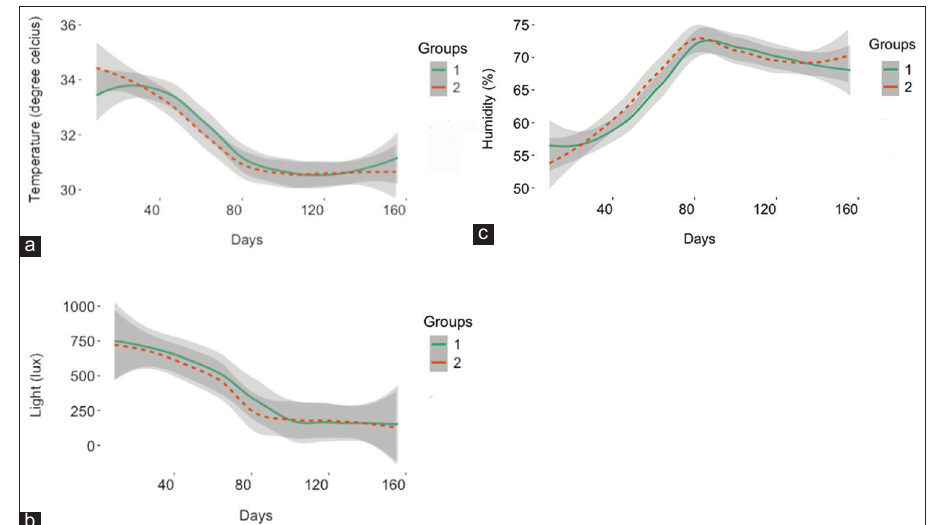
Figure-3: Trend in environmental temperature, humidity, and light for the duration of the gilt development (between March and September, n = 161 days). (a) Temperature (°C) (b) humidity (%) and (c): Sunlight radiation (lux). Graph was obtained from locally weighted regression. Temperature and light had a decreasing trend through the study period while humidity had an increasing trend. Temperature was highest from day 1 to 60, corresponding to days from March 23 and May 21. Average daily temperature declined significantly from day 80 (in June) to approximately 31 o C through the study period. Humidity increased exponentially, reaching its peak of approximately 74% on day 80 but it never went below 70% thereafter. Light on the other hand decreased from a high of 750 lux on day 1 to values below 250 lux by day 80 and remained so throughout the study. The dotted line represents Group 1 and the continuous, Group